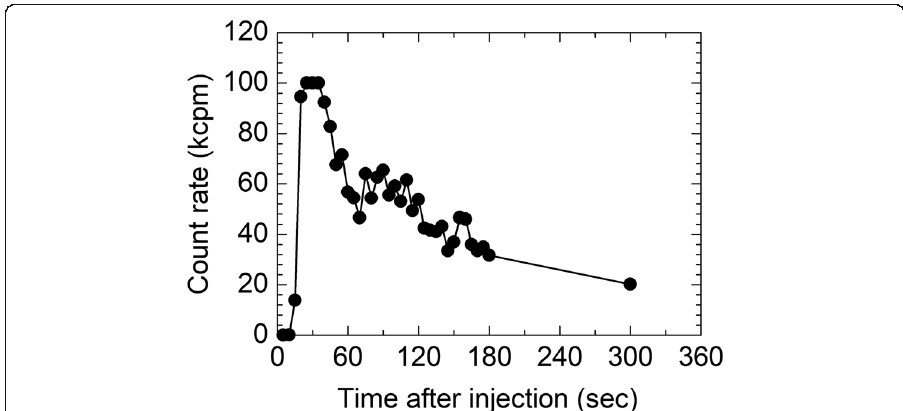
Fig. 3 Time activity curve obtained in direct measurement of α -particles in breath of patient by an α survey meter from the start of 223 RaCl 2 administration. The count rate exceeded the measurable range (100 kcpm)